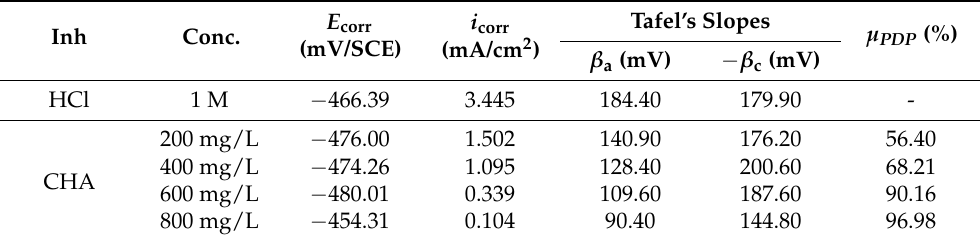
Table 2. Electrochemical parameter values extracted from PDP plots in the presence and absence of various tested concentrations of CHA extract at temperature of 298